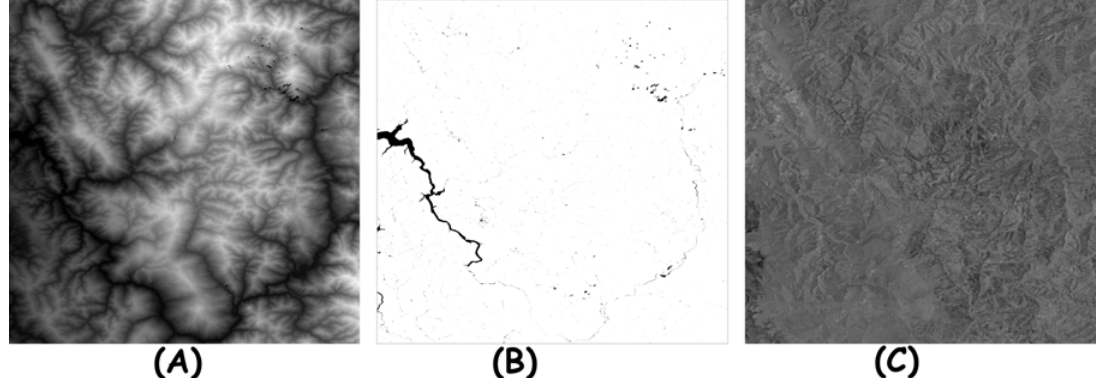
than 1 o . (c) Elevation difference image (NED DTM minus SRTM DSM). Values were